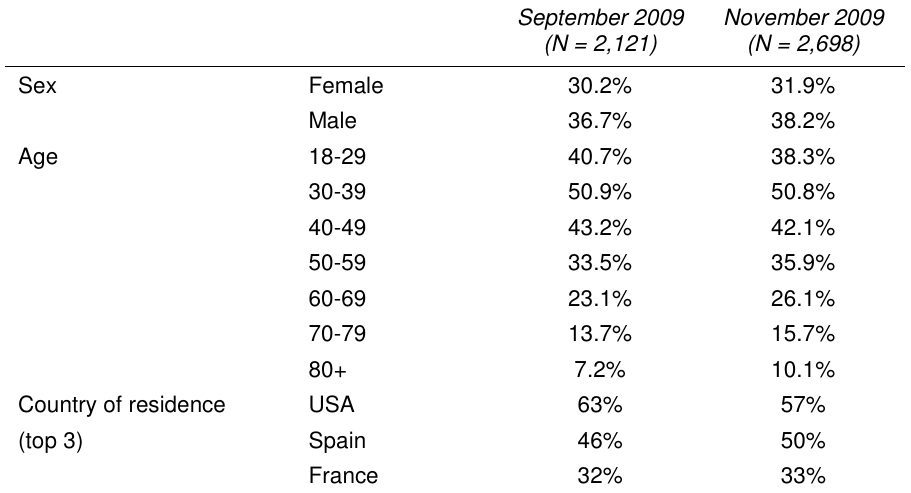
Table 2: Socio-demographic profile of Geneva’s expatriate voters in the first two internet voting trials